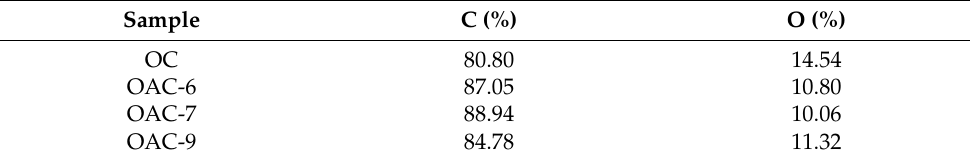
Figure 5. ( a ) Full-survey XPS spectra of OC, OAC − 6, OAC − 7, and OAC − 9. High-resolution XPS spectra of ( b ) C 1s, ( c ) O 1s for OAC − 9. Table 2. XPS element content of OC, OAC − 6, OAC − 7, and OAC − 9.